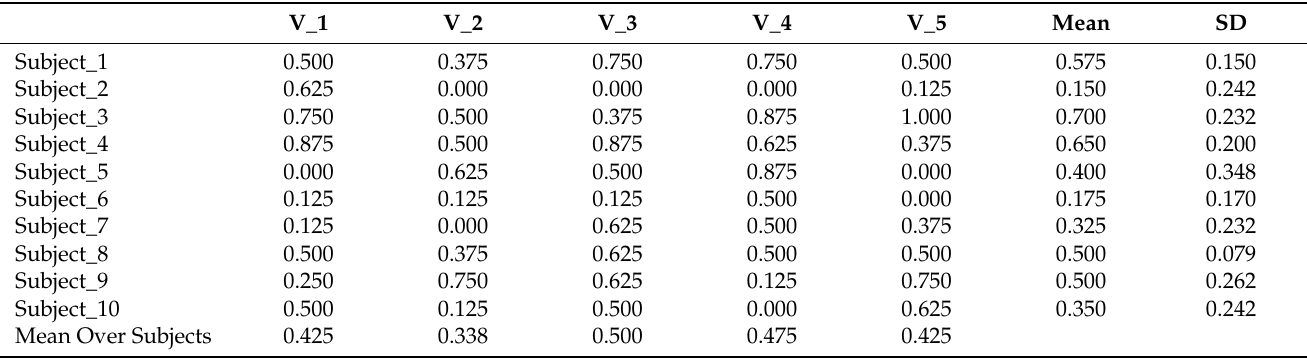
Table 1. Valence scores per subject and per hotspot.